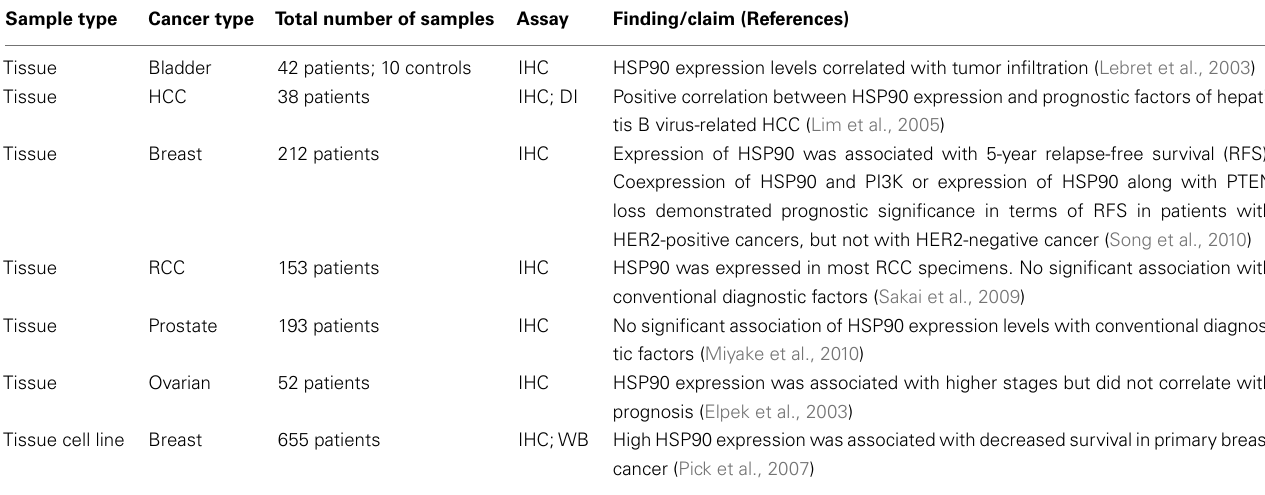
Table 4 | Selection of recent publications assessing HSP90 as a biomarker in